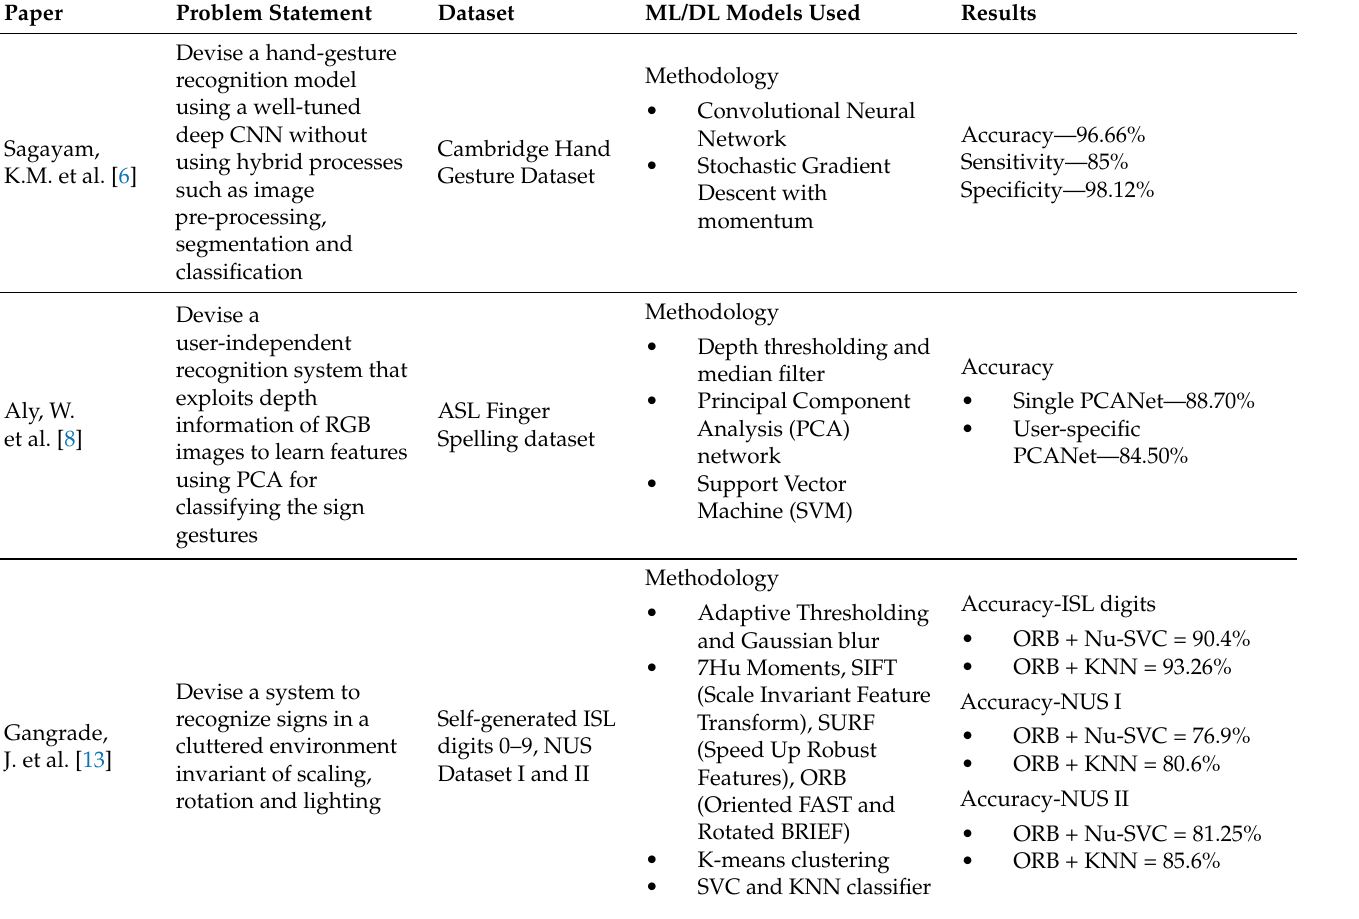
Table 1. Base papers for